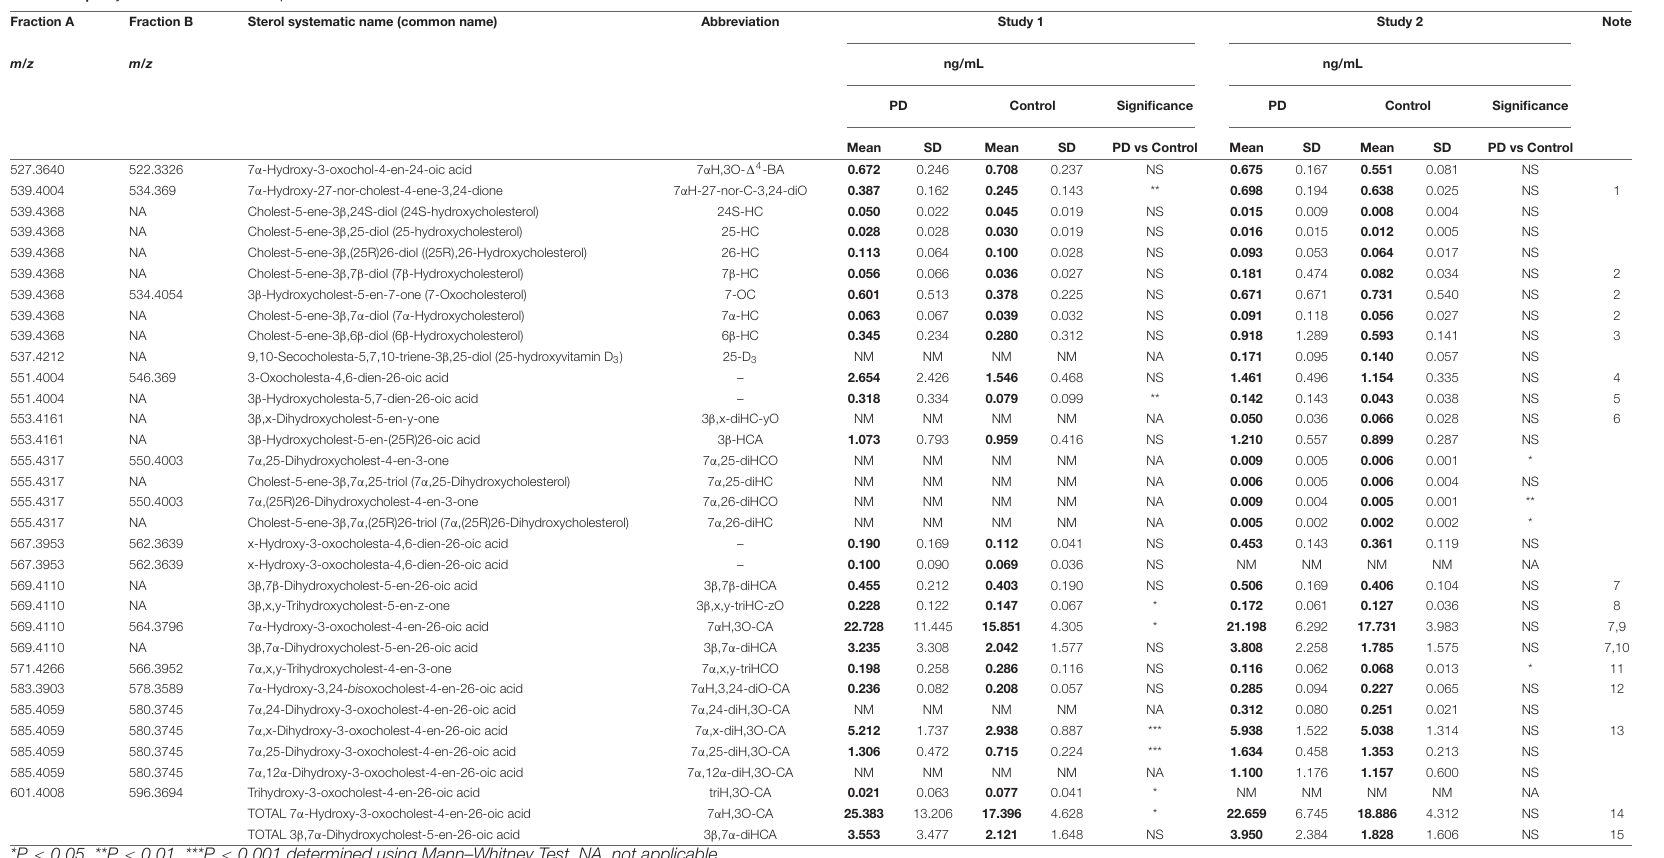
TABLE 2 | Oxysterols in CSF of PD patients and controls.